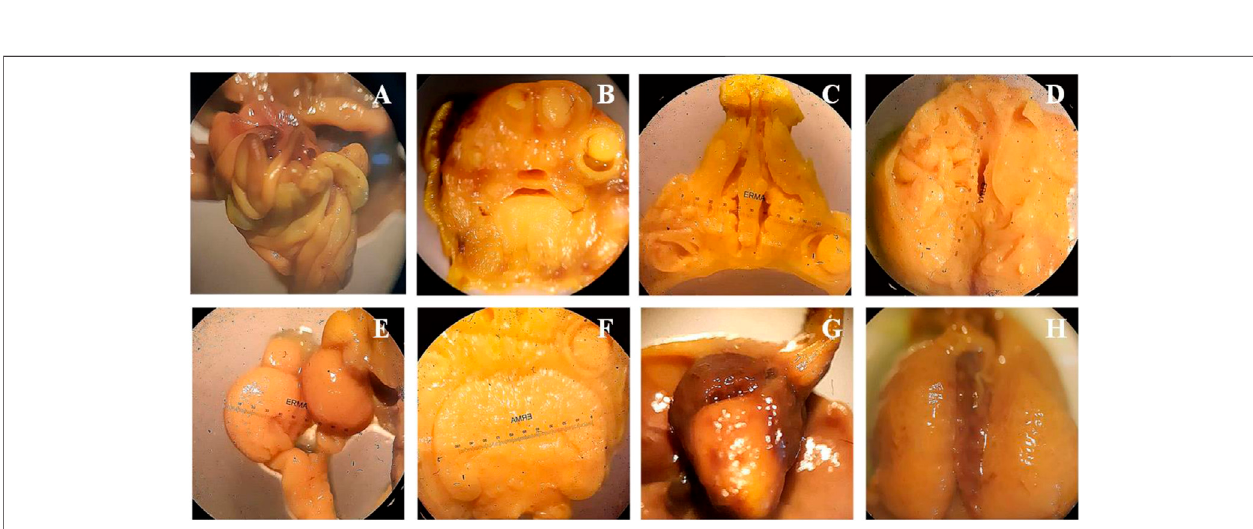
FIGURE 4 | Wilson ’ s technique for soft tissue examination. (A) : intestine, (B) : frontal Head section, (C) : palate section, (D) : no hydrocephalus, (E) : kidney, (F) : 3rd lateral ventricle, (G) : heart, (H) : liver.